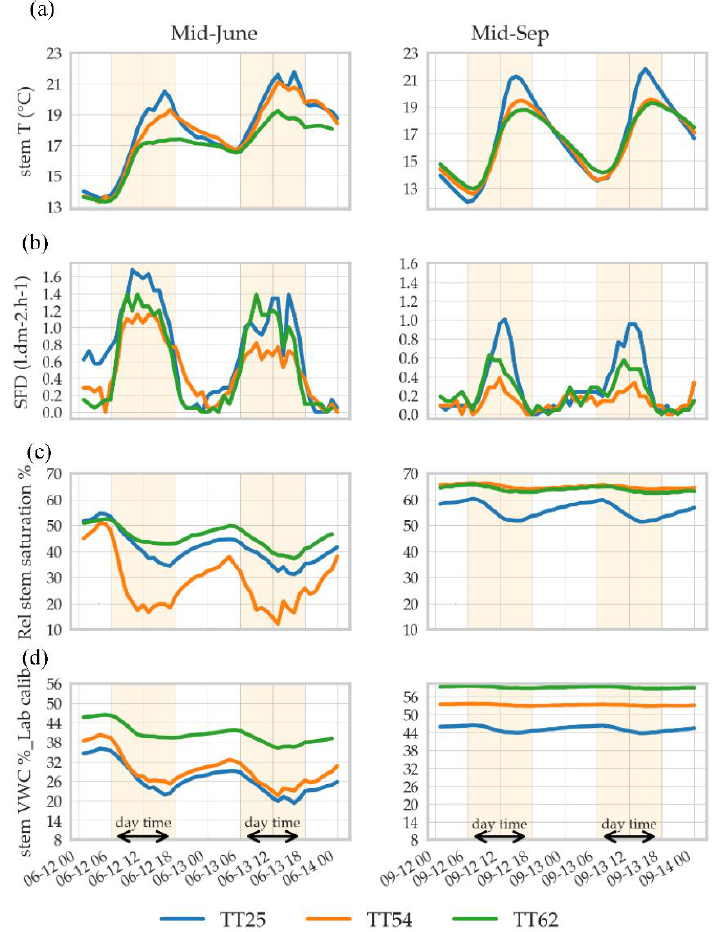
Figure 11. Individual behavior for three selected trees (25, 54, and 62) based on available ancillary data toward ( a ) stem temperature, ( b ) SFD, ( c ) relative stem saturation index, and ( d ) stem volumetric water content, based on TreeTalker hourly data focused on June vs. September 2020.